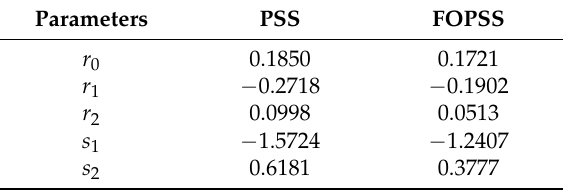
Table 6. Parameters values for the digital form of PSS and FOPSS, sampling time T S = 0.06